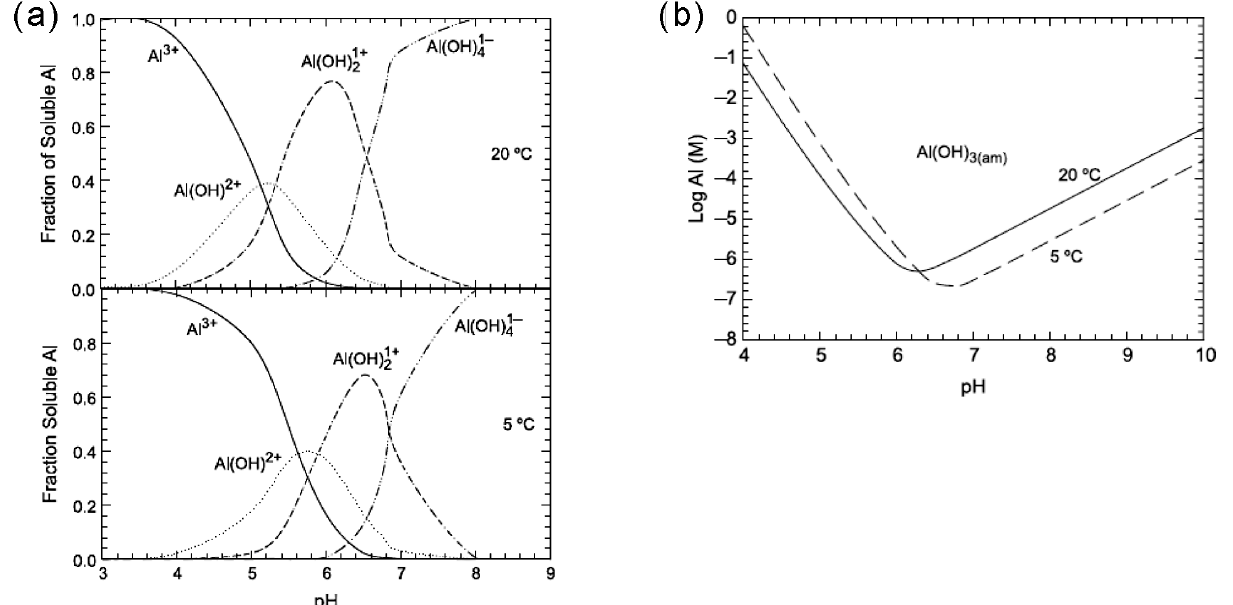
Figure 4. Distribution of aluminium hydrolysis products; (a) dissolved species; (b) amorphous precipitate (adapted from Pernitsky and Edzwald, 2006).